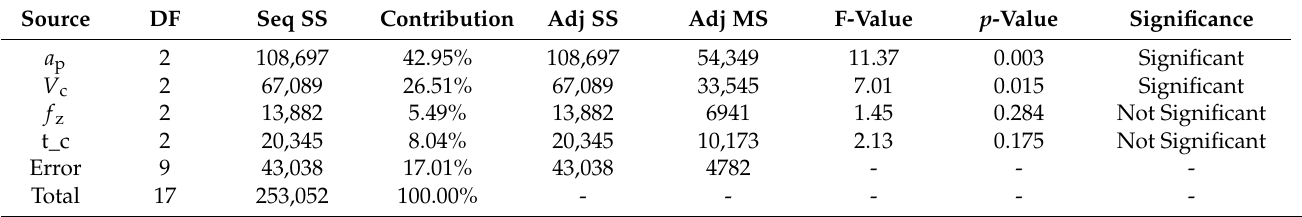
Table 9. ANOVA for burr